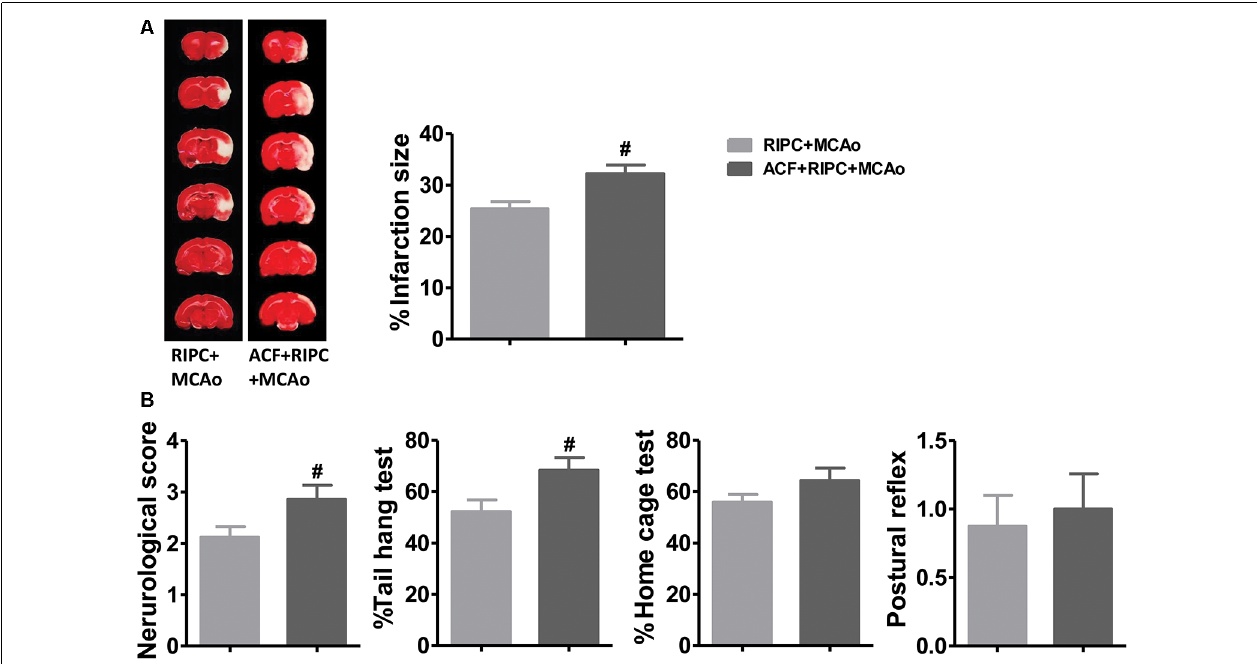
FIGURE 4 | The effects of hypoxia-inducible factor (HIF) antagonist ACF on stroke outcomes in aged stroke animals treated with RIPC. (A) Representative images of TTC staining and the statistical results of infarct volume in the RIPC+MCAo and ACF+RIPC+MCAo group in aged rats. (B) Neurological score and behavioral tests of the tail hang test, home cage test, and postural reflex test ( N = 8–10 per group). # P < 0.05, vs. RIPC+MCAo. ACF, acriflavine hydrochloride, HIF